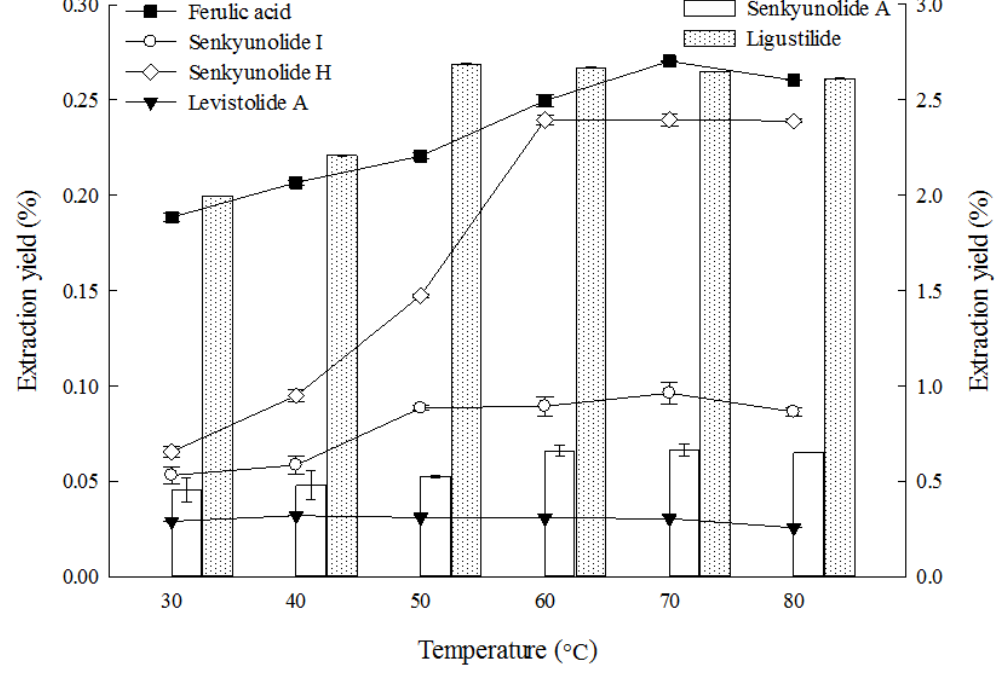
Figure 5. Effect of temperature on the extraction yields of the six constituents (the lines and bar graphs are referenced to the left and right axes,